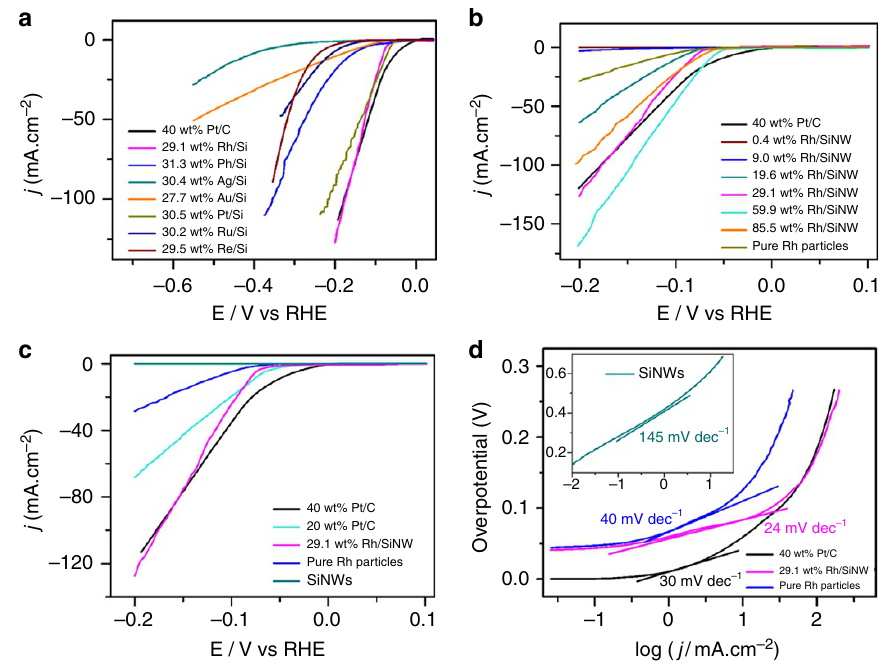
Figure 2 | The electrochemical activity of different electrocatalysts in oxygen-free 0.5M H 2 SO 4 . ( a ) LSV plots of metal/SiNW catalysts containing about 30wt% metal. The metal type is indicated. The LSV of 40wt% Pt/C is also shown. 29.1wt% Rh/SiNW has the best HER activity of all metal/SiNW catalysts. ( b ) LSV plots of Rh/SiNW catalysts with different Rh wt% with the 59.9wt% the best one. ( c ) LSV plots of SiNWs, pure Rh, 29.1wt% Rh/SiNW, and 20 and 40wt% Pt/C. The HER activity of 40wt% Pt/C is better than that of 20wt% Pt/C, so only the 40wt% Pt/C data was used as a reference to the Rh/SiNW data. The HER activity of 29.1wt% Rh/SiNW is worse than that of 40wt% Pt/C for V 4 (cid:2) 160mV but is better for V o (cid:2) 160mV. ( d ) Tafel plots and Tafel slopes derived from c . The Tafel slopes are 145, 40, 30 and 24mVdec (cid:2) 1 for SiNWs, pure Rh, 40wt% Pt/C and 29.1wt% Rh/SiNW, respectively. The Tafel slope of 29.1wt% Rh/SiNW is smaller than that of 40wt% Pt/C indicating the better HER performance of 29.1wt%